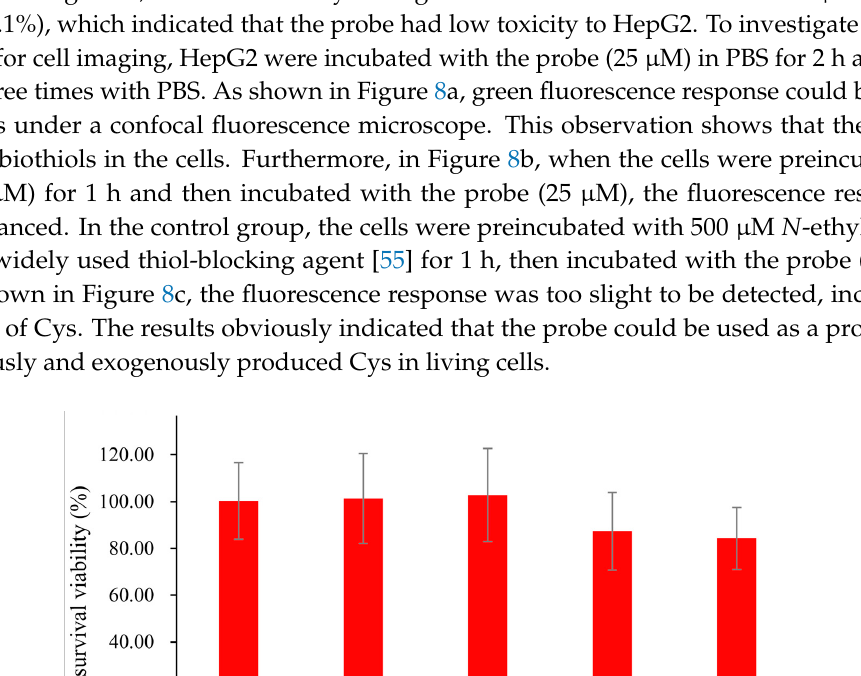
Figure 7. MTS assay of HepG2 cells incubated in the presence of the probe (0–27 μ M) at 37 °C for 24 h.